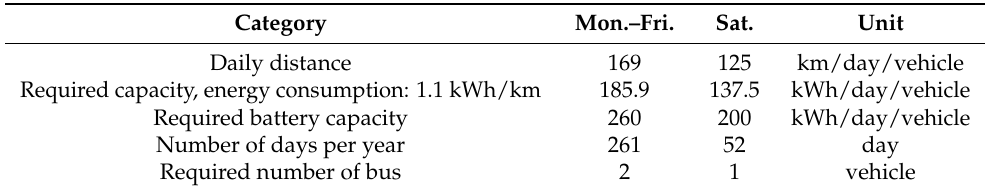
Table 2. Line information of line S5 and S7 for 2 buses